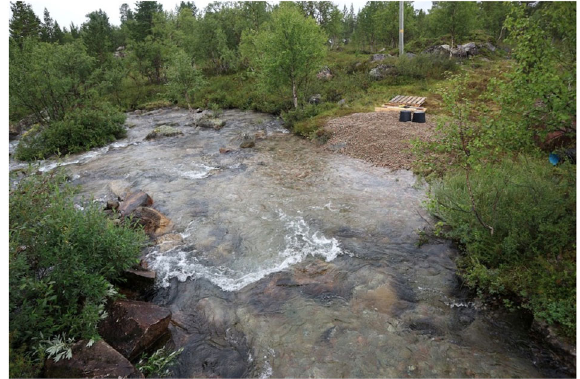
Fig. 4 Restored gravel area and river site in the Skolt Sámi home area. On the right restoration gravel for fi sh spawning areas is still visible. Photo: